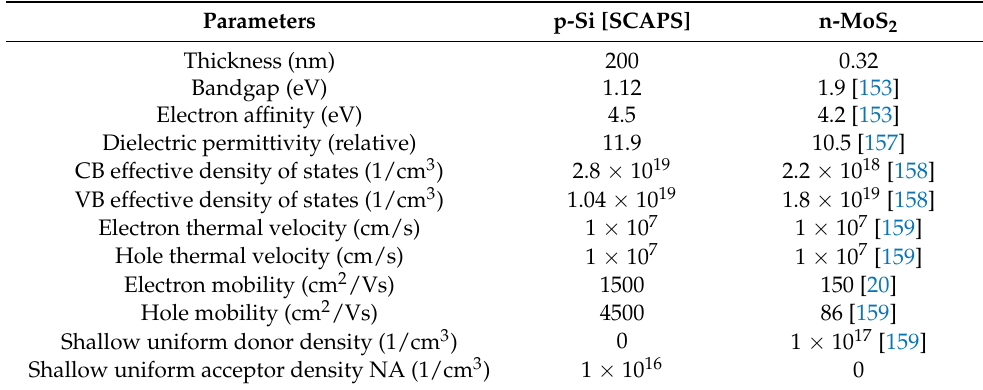
Table 7. Physical parameters of n-MoS 2 monolayer and p-Si substrate used in the SCAPS-1D™ simu- lations.